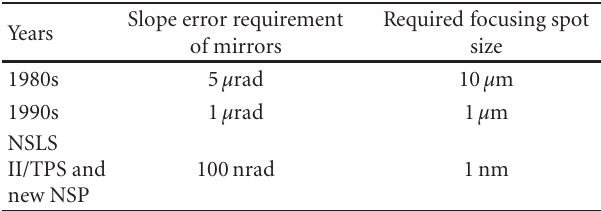
Table 1: Di ff erent requirements for the slope error of mirrors and the focusing-spot size at di ff erent